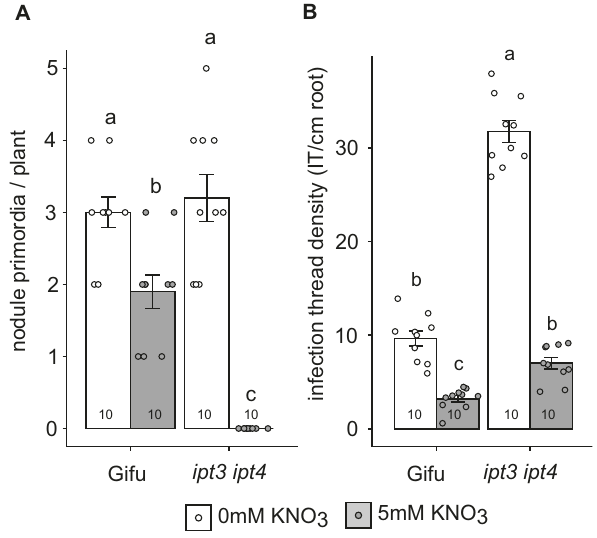
Fig. 4 Ipt3 and Ipt4 contribute to maintenance of nodule initiation in the presence of nitrate. A Nodule primordia number in the absence and presence of 5 mM KNO 3 at 7dpi with M. loti . B Infection thread density in the absence and presence of 5 mM KNO 3 at 7dpi with M. loti . Bars show mean ± SE with signi fi cant differences between genotypes and nutrient conditions indicated by letters ( p < 0.05) as determined by ANOVA and Tukey post-hoc analysis. Pairwise P -values are available in the Source Data fi le. The n values of each group are shown.